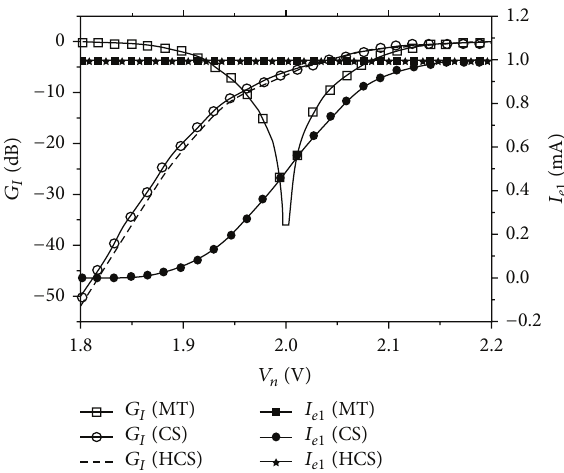
Figure 3: Transimpedance gain and its bandwidth versus bias . current I e 1